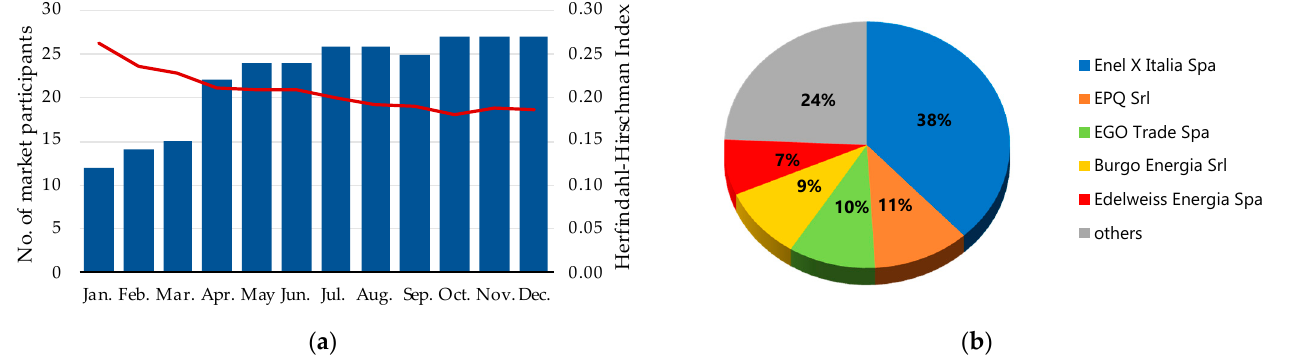
Figure 4. Development of monthly auctions during the first year of implementation for ( a ) Zone A; ( b ) Zone B.